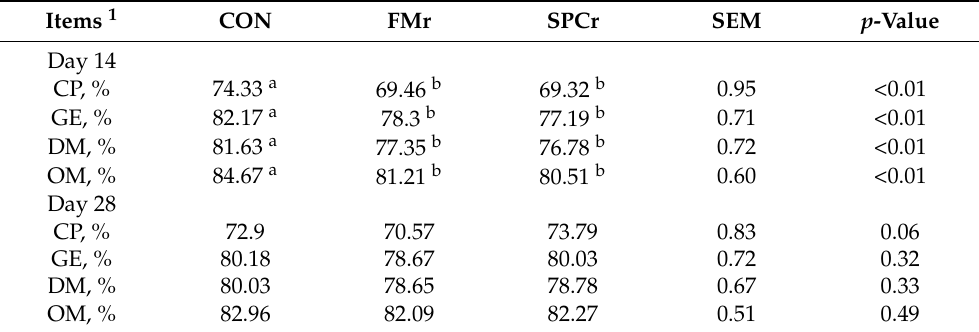
Table 4. Effects of replacing fish meal and soybean protein concentrate with degossypolized cotton- seed protein on apparent total tract digestibility in weaning pigs.